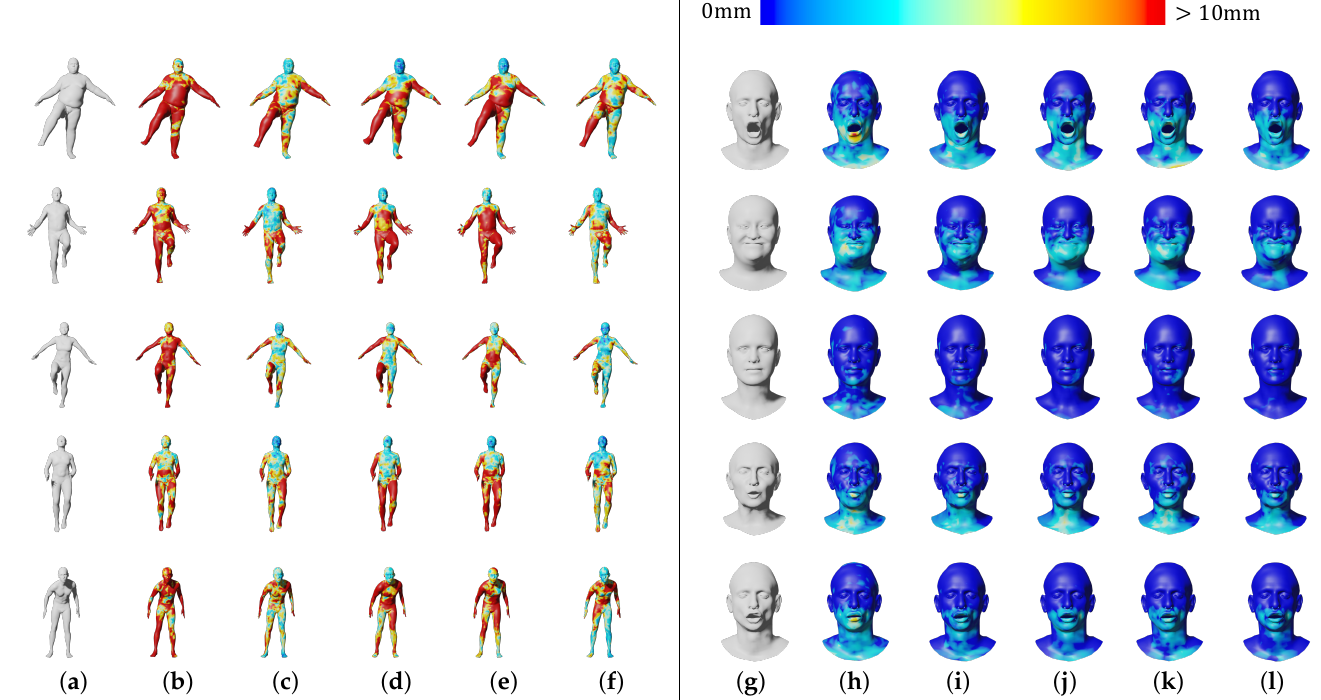
Figure 6. Qualitative comparison of reconstruction errors. ( a – f ): DFAUST dataset, ( g – l ): CoMA dataset.